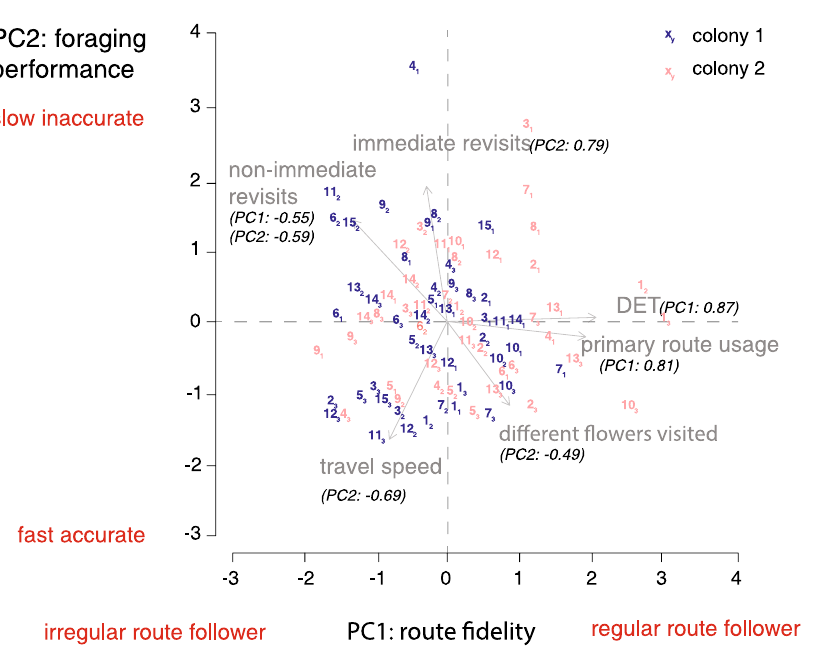
Figure 3. Correlations between the two first components (PCs) of the principal component analysis (PCA). Grey arrows represent the six behavioural measures on PC1 (route fidelity) and PC2 (foraging performance). PC loadings are in brackets. Only loadings > |0.4| were retained (see Supplementary Table S3 for the complete PCA loadings). Each data point represents the PC1 and PC2 scores of a given bee in each experimental array. The PCs define a continuum between four behavioural extremes: fast accurate and regular route followers, fast accurate and irregular route followers, slow inaccurate and regular route followers, slow inaccurate and irregular route followers. Blue: colony 1 (N = 15 bees, 45 data points), red: colony 2 (N = 14 bees, 42 data points). Numbers refer to individual bees (same number code as in Figs 4 and 5). Subscripts refer to experimental arrays